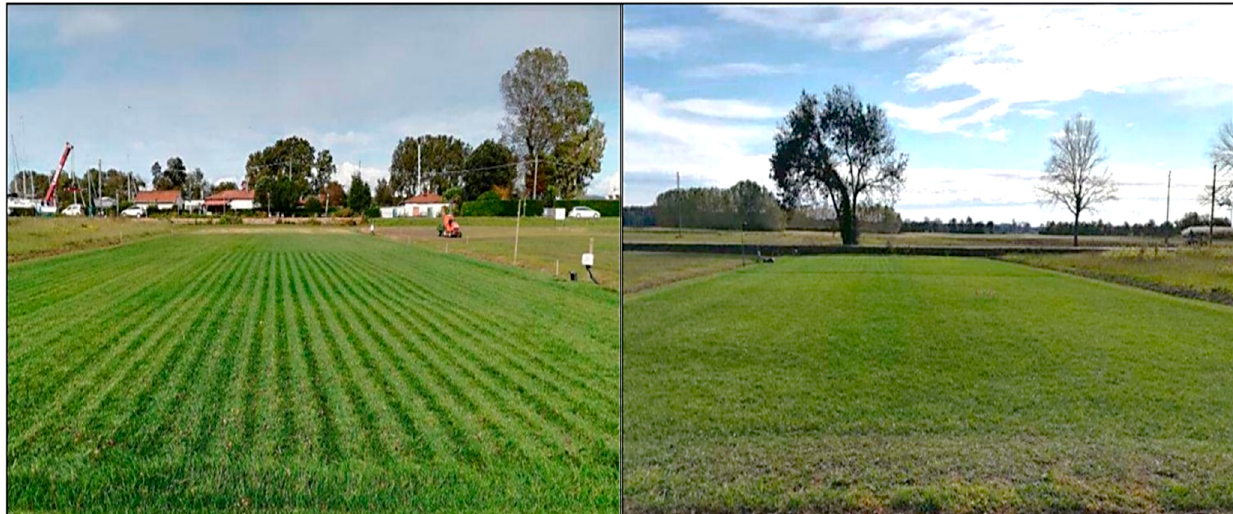
Figure 5. Visual effect of different autonomous mower operating patterns on tall fescue turf trial 2 on 10 October 2020. ( Left ) systematic trajectories operating pattern. ( Right ) random trajectories operating pattern.